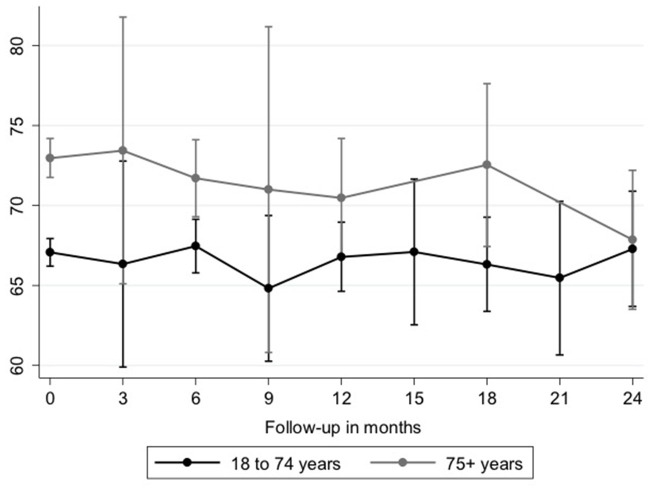
Longitudinal course of FVC (% pred.). FVC decline is shown in elderly (gray line, n = 148) and nonelderly (black line, n = 294) patients with IPF. Differences were not statistically significant. FVC, forced vital capacity; IPF, idiopathic pulmonary fibrosis.